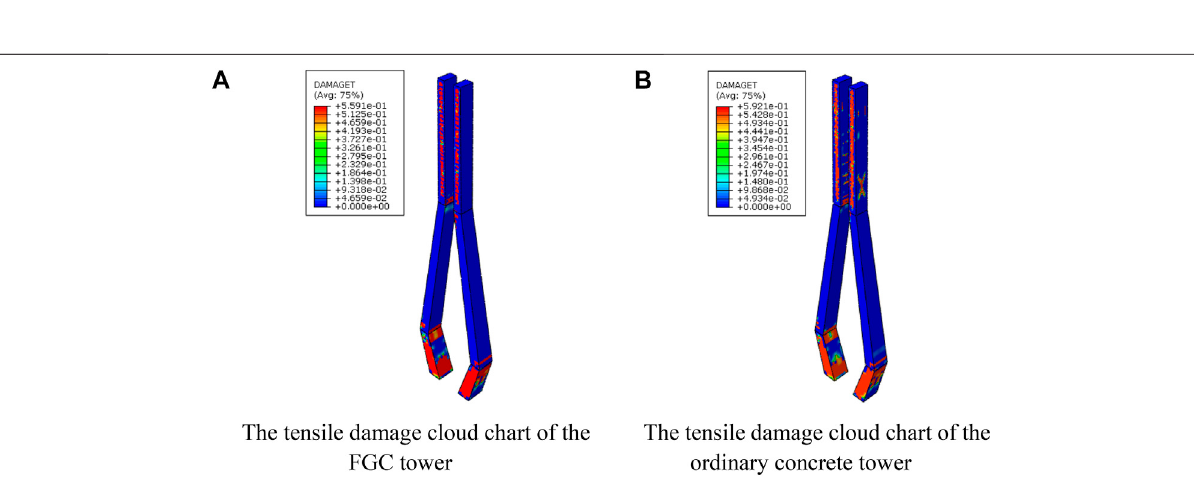
Frontiers in Materials |